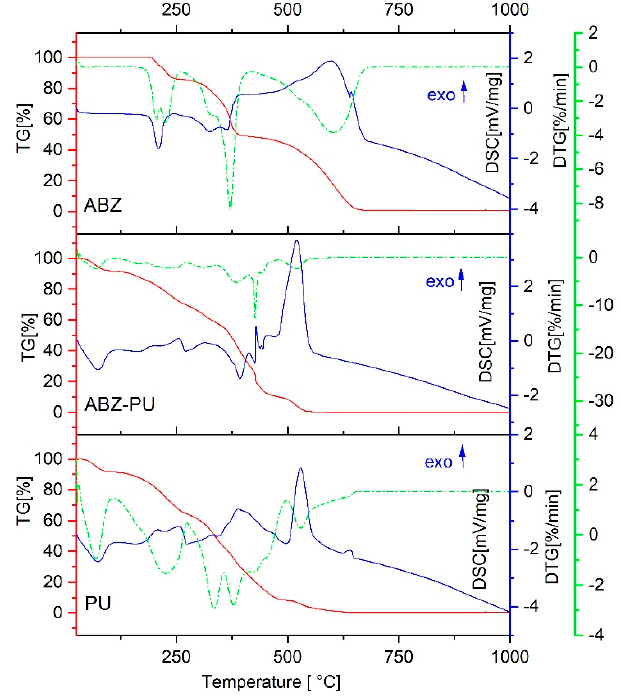
Figure 1. Thermal analysis—TG (red), DSC (blue) and DTG (green).